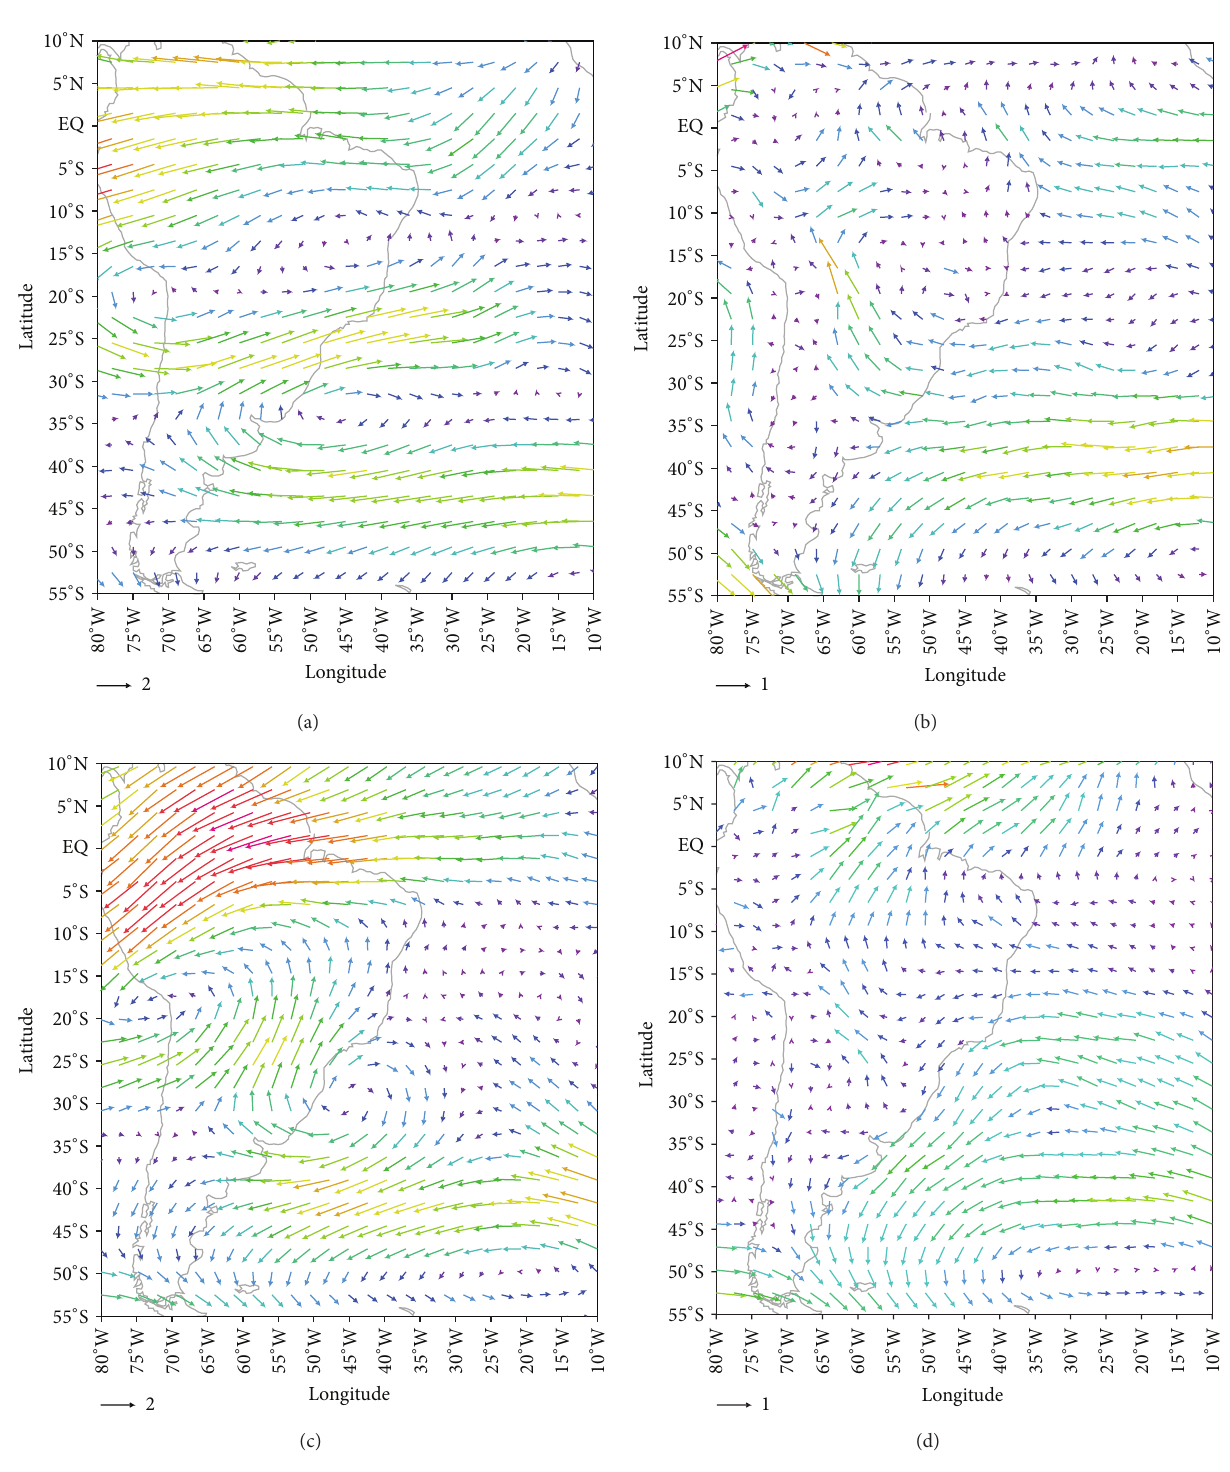
Figure 6: Annual mean horizontal wind (ms −1 ) anomaly for HCSA strong cases in the period 1996–2011 based on the Era-Interim reanalysis at (a) 200 hPa and (b) 850 hPa and RegCM4 simulation at (c) 200 hPa and (d) 850 hPa. The color scale represents the vector’s